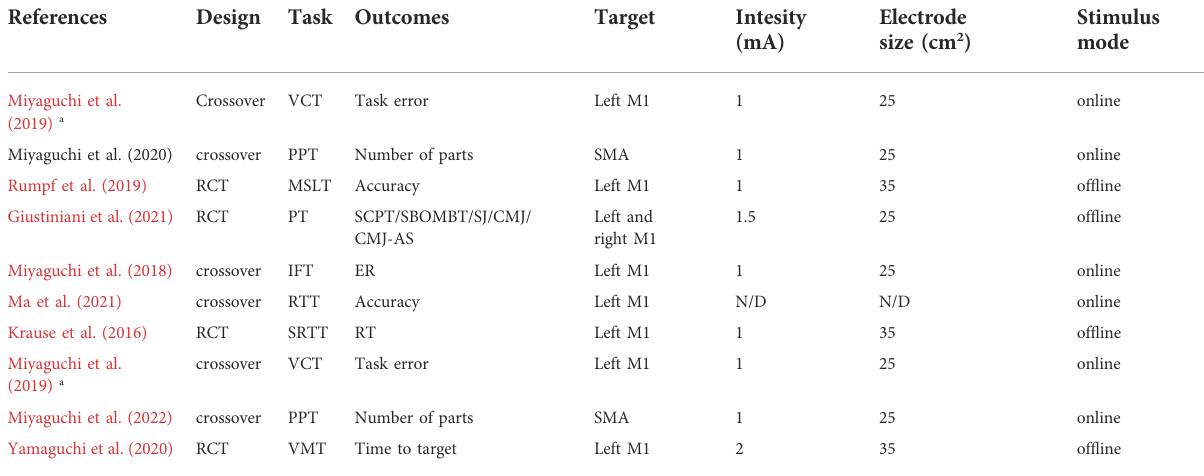
TABLE 2 Characteristics of the included